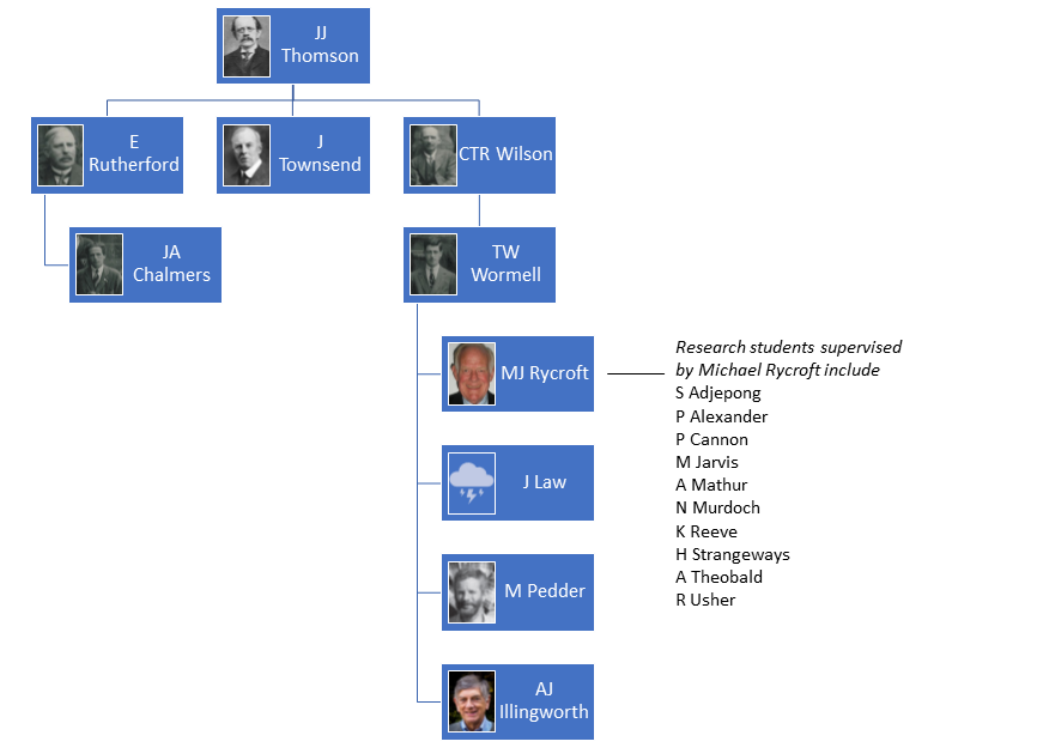
Figure 9. The Cavendish Laboratory atmospheric electricity “family tree”, highlighting the contribution of Michael Rycroft. The group formed by Chalmers at Durham is described by Aplin (2018). Mike Pedder spent his career at Reading in the Department of Meteorology, subsequently joined there by Anthony Illingworth after working at University of Manchester Institute of Science and Technology (UMIST). John Law became a hospital health